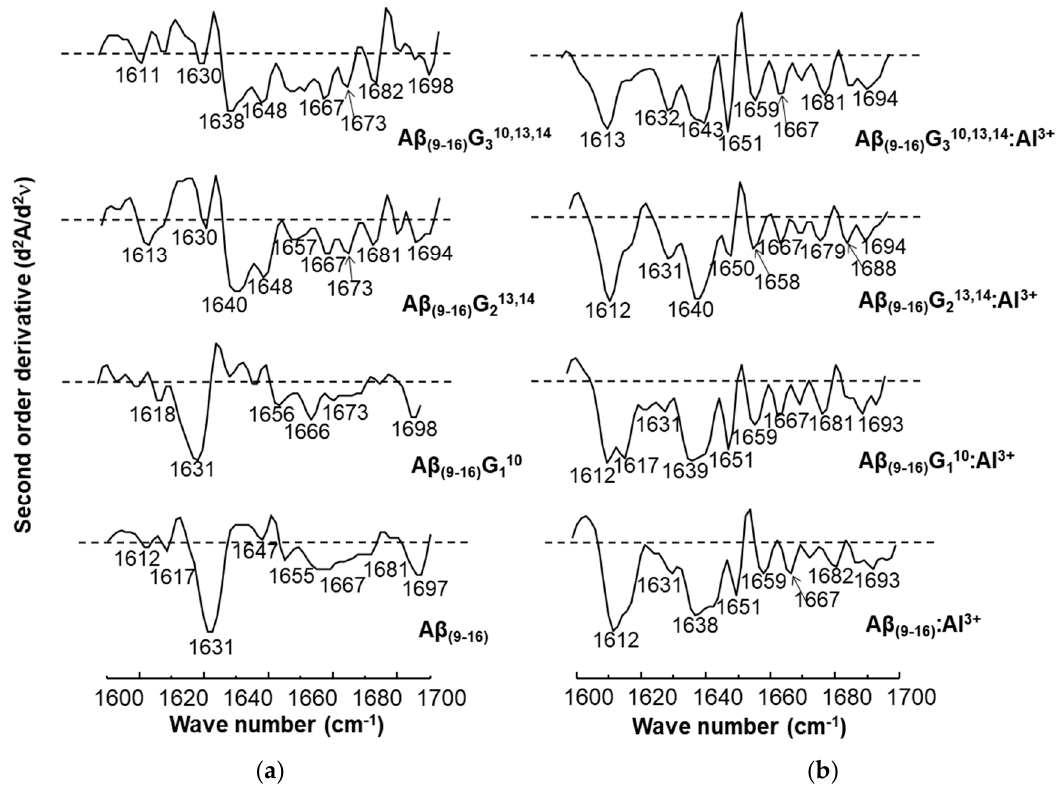
Figure 9. Second-order derivatives of the FT-IR spectra of amyloid peptides calculated in the range 1600-1700 cm − 1 : ( a ) in the absence of aluminium ions; ( b ) in the presence of aluminium ions.